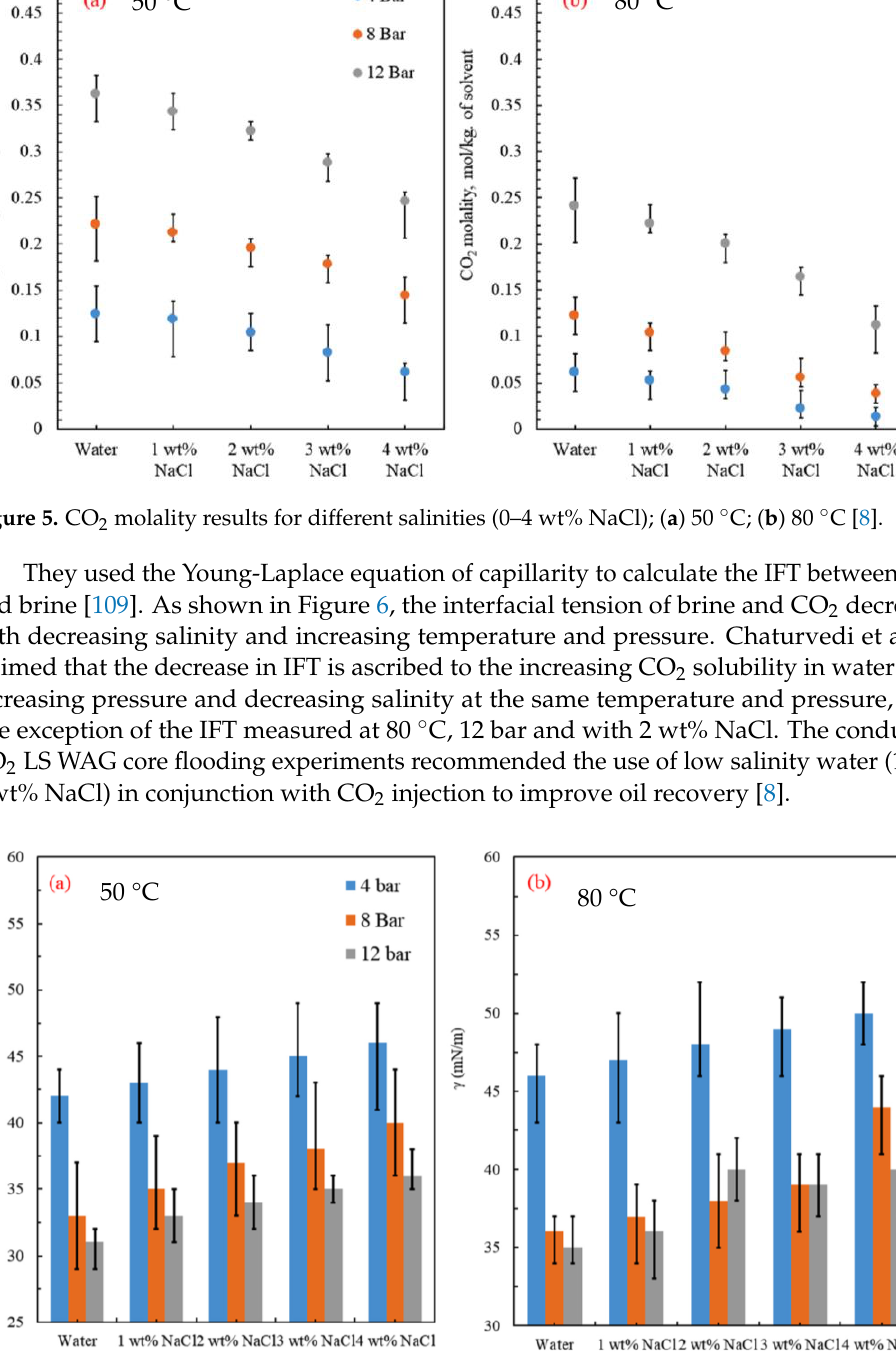
Figure 6. CO 2 − brine solution interfacial tension at different pressures (4–12 bar) and temperature of ( a ) 50 °C; ( b ) 80 °C [8].